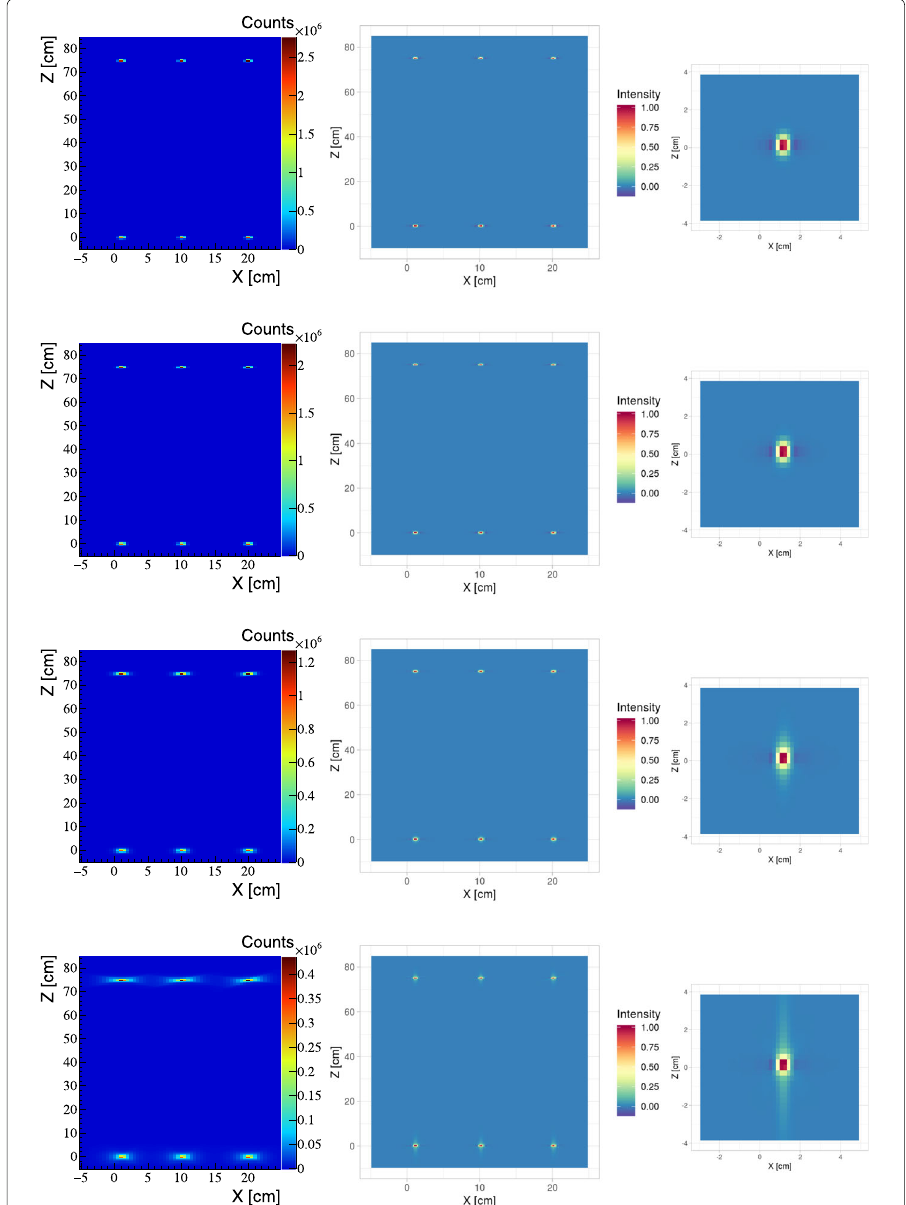
Fig. 5 Left: Reconstructed distribution of annihilation point spatial coordinates. The voxel size is equal to 5 × 5 × 5 mm 3 . Middle: Reconstructed image of six sources obtained while applying the TOF-FBP algorithm. The voxels: 1.8 × 1.8 × 2.9 mm 3 . Right: Reconstructed source placed at ( x , y , z ) = ( 1,0,0 ) cm. Each row show results with different resolution: CRT = 10 ps (top row), CRT = 50 ps (second row), CRT = 140 ps (third row), and CRT = 500 ps (bottom